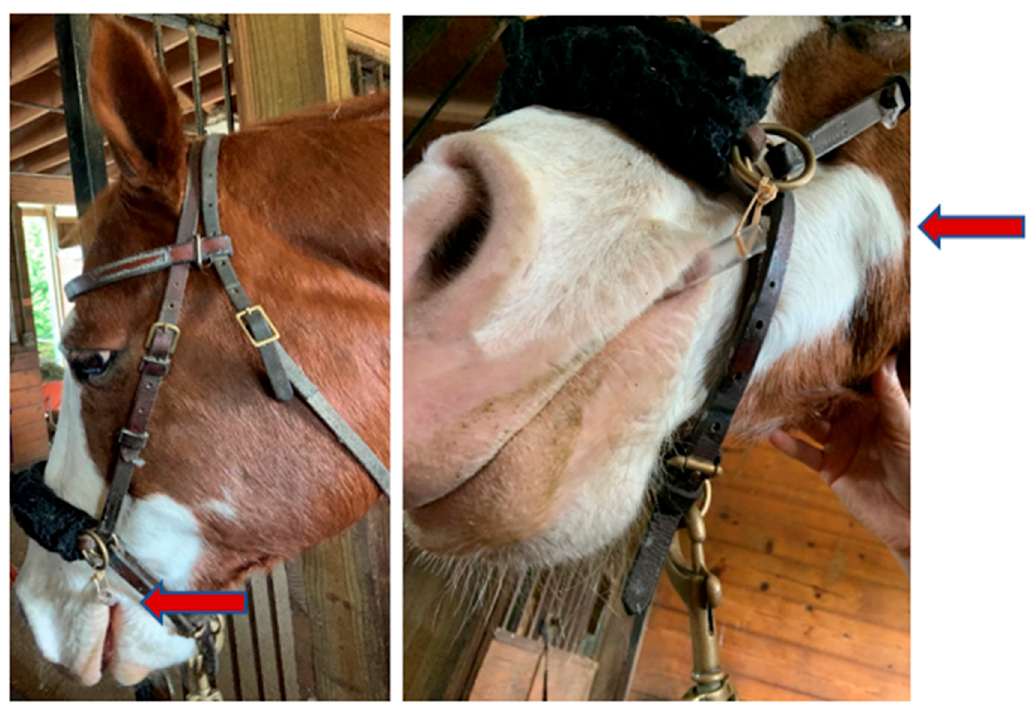
Figure 2. The Modified Bit Attached to The Bitless Bridle for Collection (side and front views).